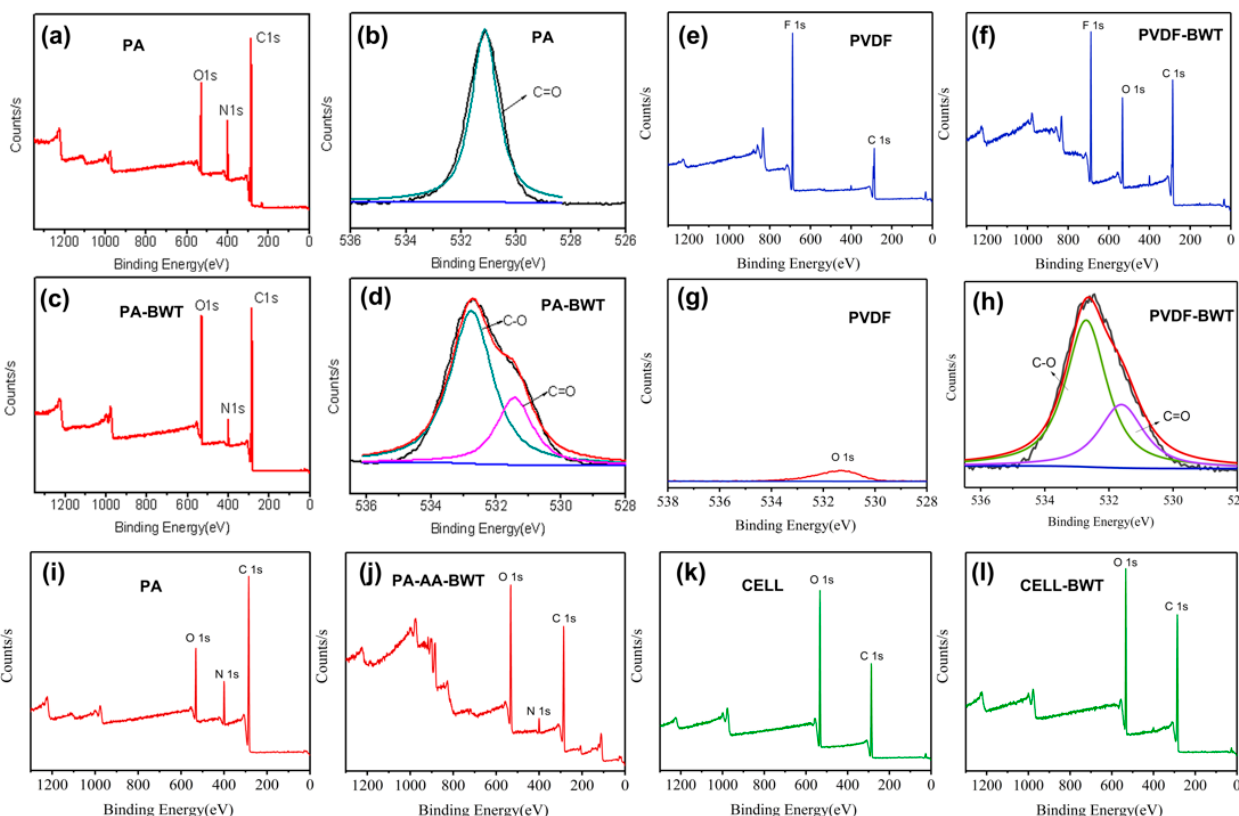
Figure 3. High resolution XPS spectra and O 1s spectra of ( a – d ) PA and PA-BWT, ( e – h ) PVDF and PVDF-BWT, ( i , j ) PA and PA-AA-BWT, and ( k , l ) CELL and CELL-BWT.